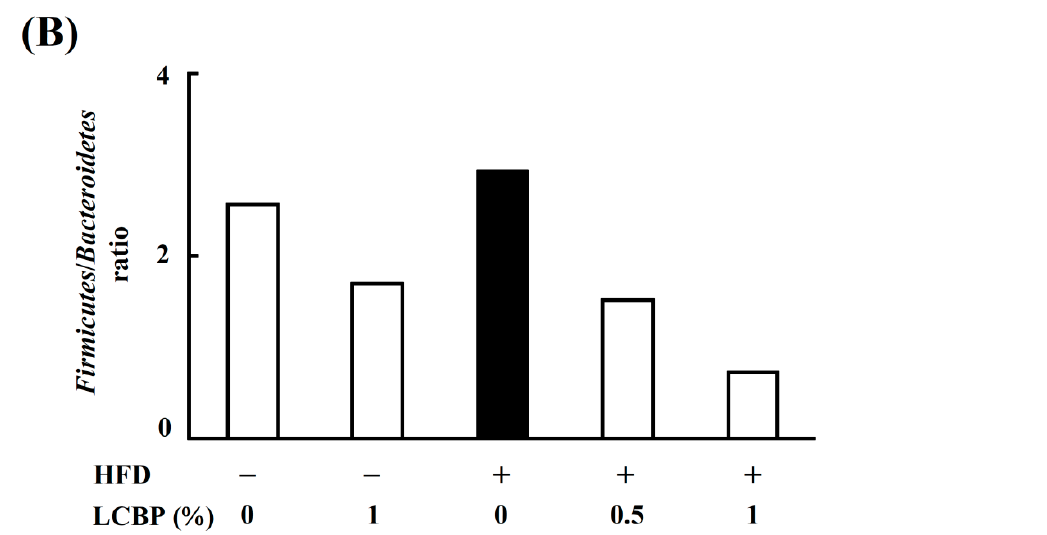
Figure 3. Modulation of gut microbiota by LCBP at the phylum level. Fecal microbiota were characterized by 16S rRNA gene sequencing. ( A ) The relative abundance of bacteria including Verrucomicrobia , Proteobacteria , Firmicutes , Deferribacteres, Bacteroidetes and Actinobacteria , at the phylum level. ( B ) The ratio of Firmicutes to Bacteroidetes , based on their relative abundance. HFD, high fat diet; LCBP, Lonicera caerulea L. berry polyphenols.